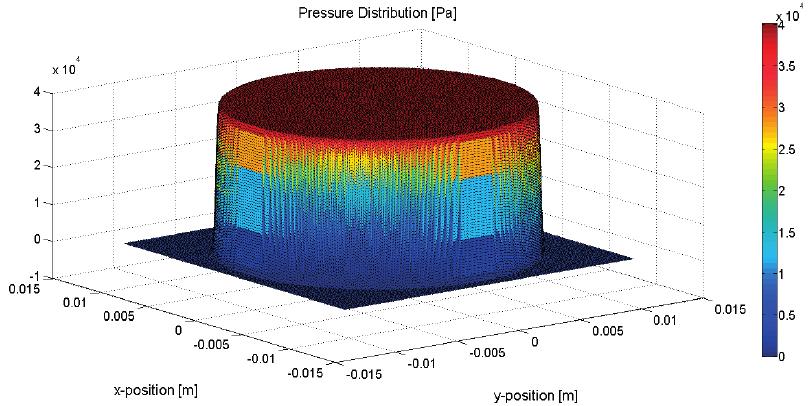
Figure 3. Pressure distribution of the generated ultrasound